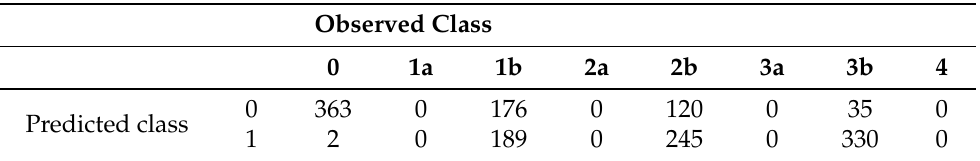
Table 6. Detailed confusion matrix for the RF model and the two-class classification. All anomalous samples are separated into the original scenarios.